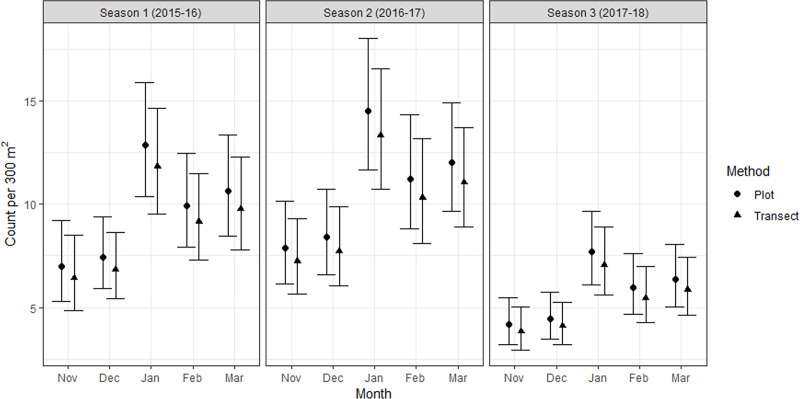
The predicted mean number (± SE) of B. robustus grasshoppers within the 300 m2 sampling area using plot searches (12 plots x 25 m2) and transect searches (3 transects x 100 m2) at Patersons Terrace during the monitoring period (November–March) for three seasons (2015–16 to 2017–18).Excludes grasshoppers less than 8 mm in body length.